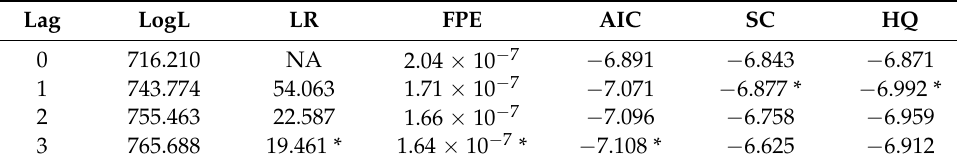
Table 4. Selection of lag